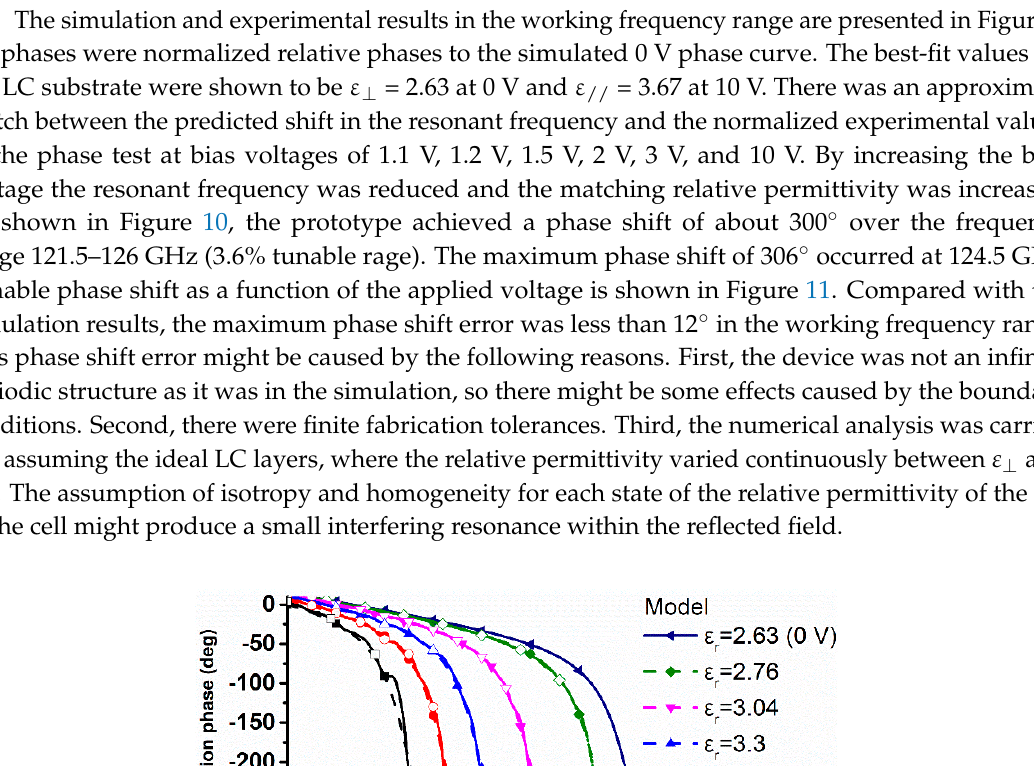
Figure 10. Comparison between the measured and simulated maximum reflection phase difference.